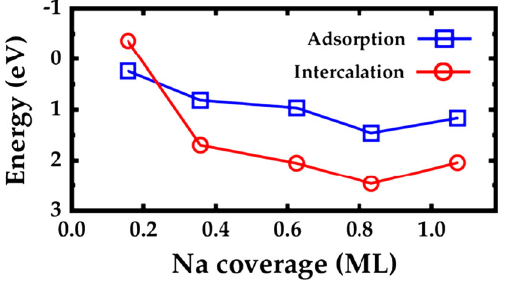
FIG. 2. Adsorption and intercalation energies as a function of the Na coverage.